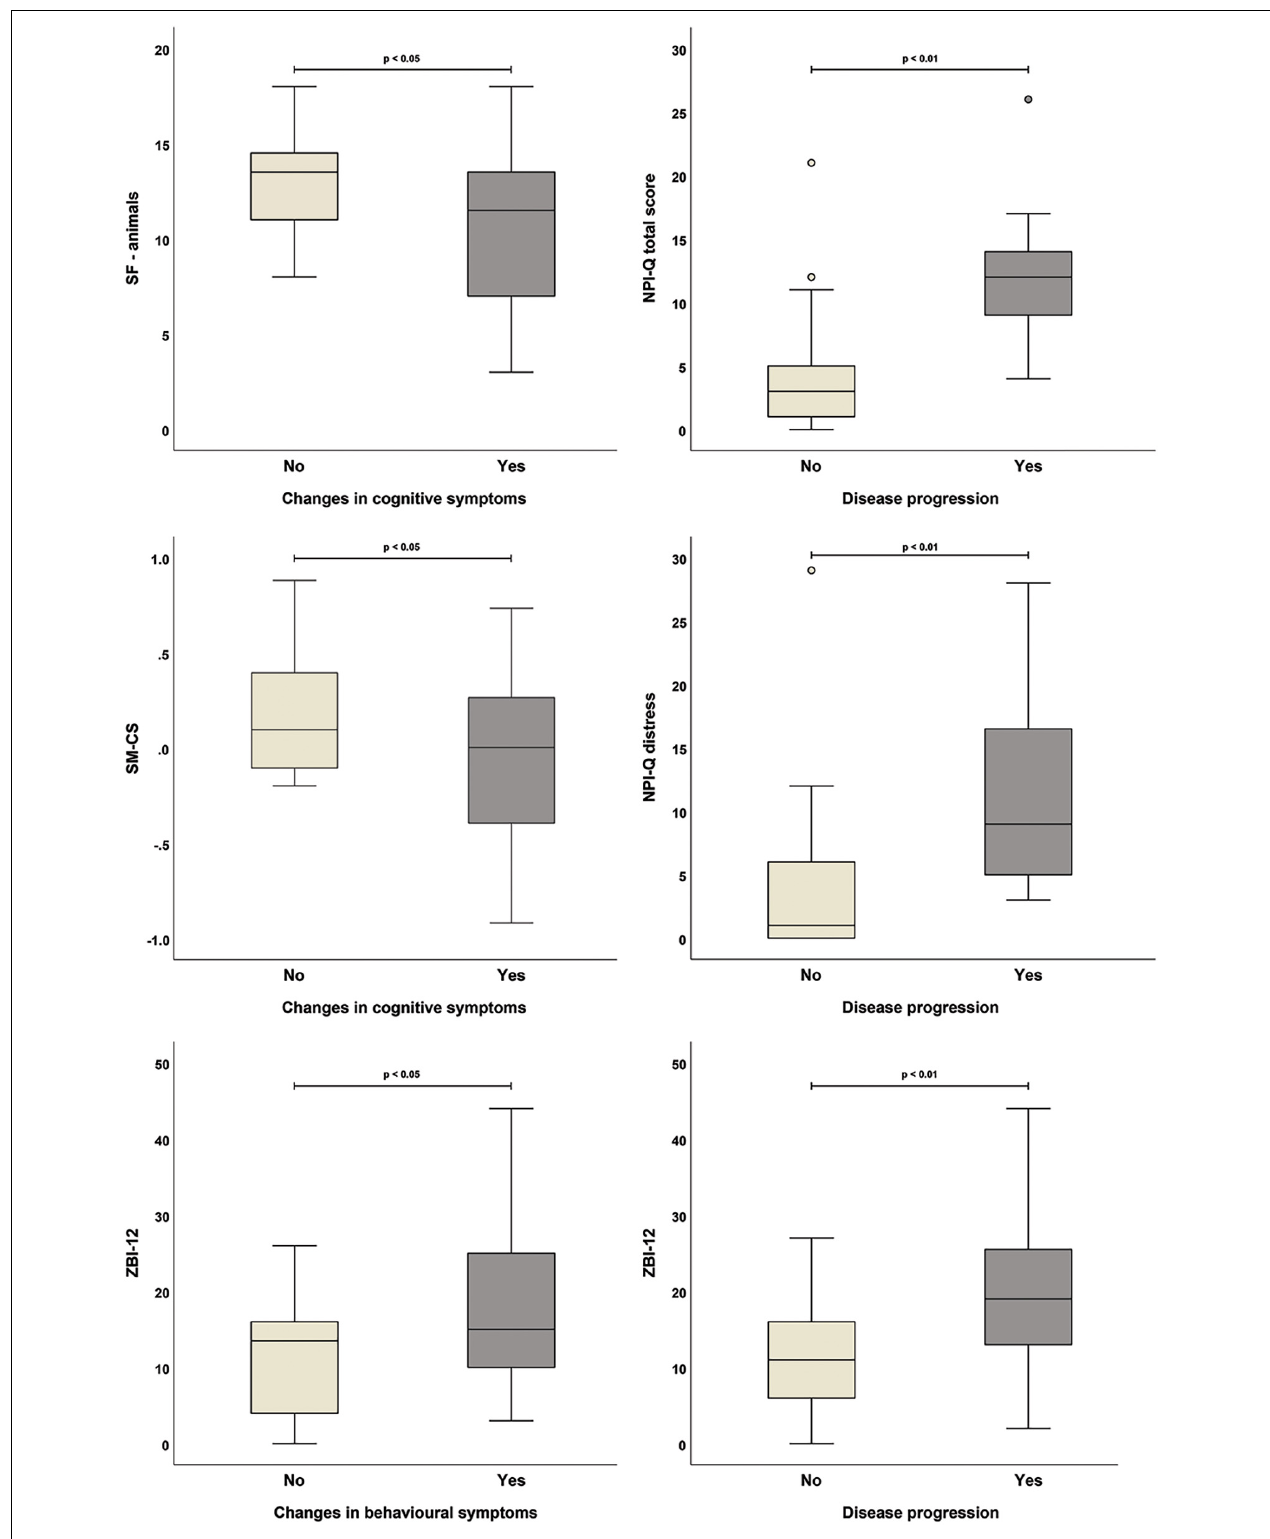
FIGURE 2 | Significant associations between carer-reported changes in patients’ symptoms and outcome measures collected at T0 (all variables were treated as binary: yes, symptom changes/faster progression reported by carer; no, carer reported no symptom changes/faster progression).